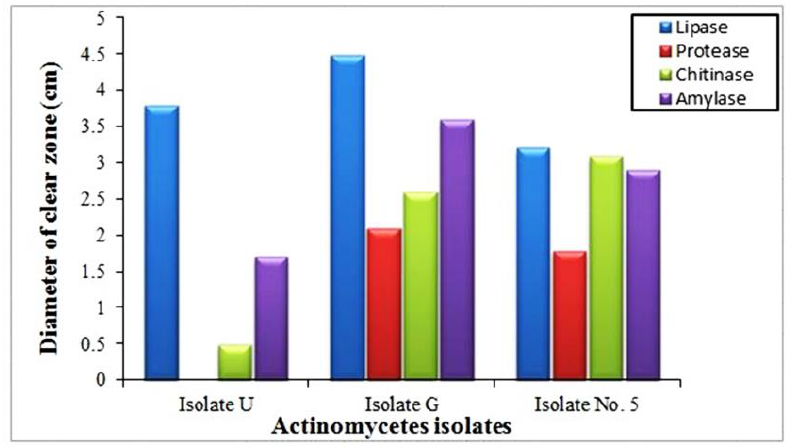
Figure 5. Enzymatic activities (lipase, protease, chitinase, and amylase) of tested potential antago- nists (isolates U, G, and No. 5). Isolate U lacks protease properties.